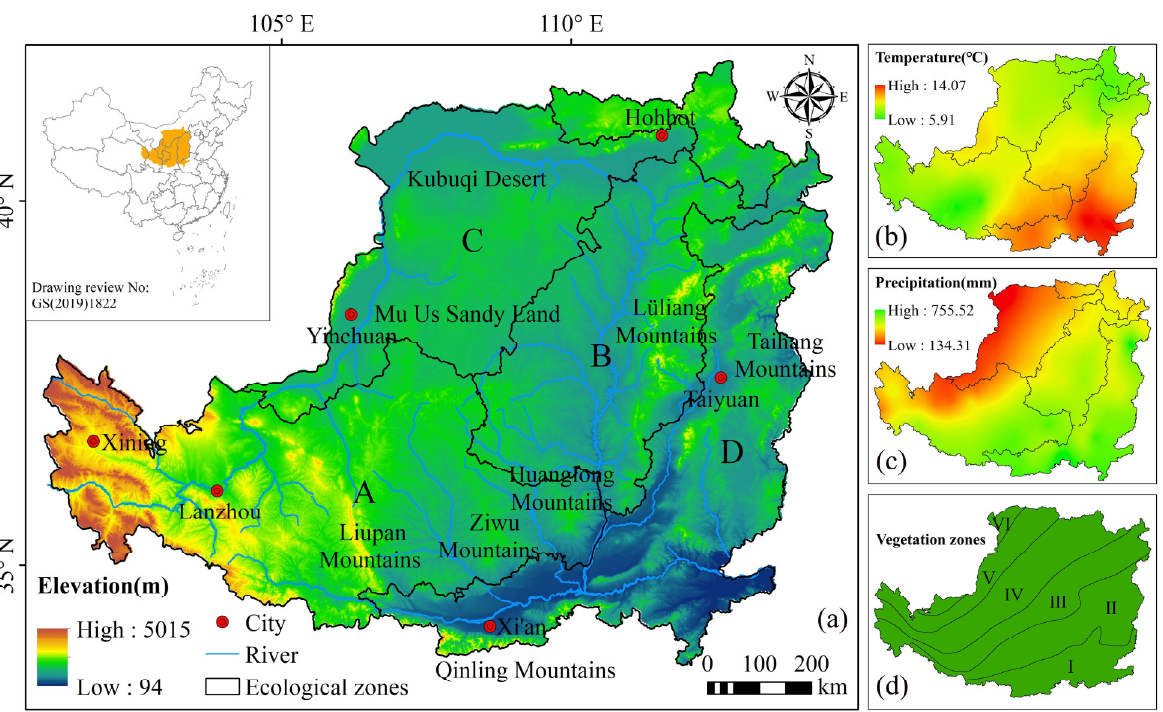
Figure 1. Schematic diagram of the LP: ( a ) ecological zoning of the LP: (A) loess sorghum gully region; (B) loess hilly and gully region; (C) sandy land and agricultural irrigation region; (D) earth– rocky mountainous and river valley plain region. ( b ) spatial distribution of average temperature on the LP from 2000 to 2020. ( c ) Spatial distribution of mean precipitation on LP from 2000 to 2020. ( d ) vegetation zoning in the LP: Ⅰ , sub-belt of deciduous oak forest in southern warm temperate zone; Ⅱ , subzone of deciduous oak forest in northern warm temperate zone; Ⅲ , temperate forest grassland sub zone; Ⅳ , temperate typical grassland sub-zone; Ⅴ , temperate desert grassland sub-belt; Ⅵ , temperate steppe desert sub-belt.